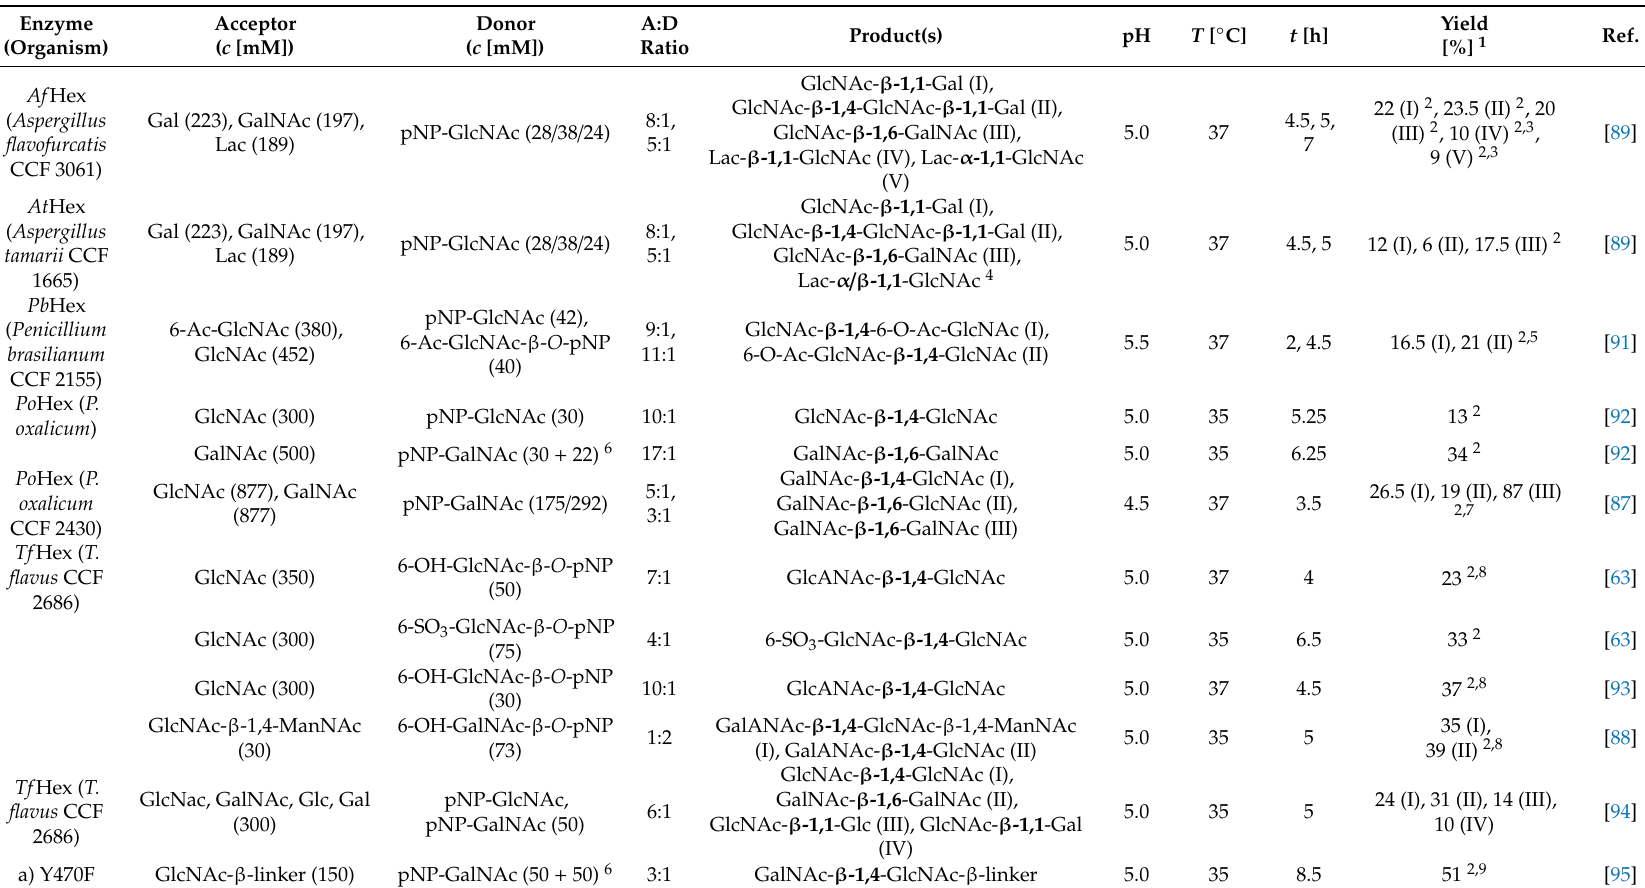
Table 4. Trans-glycosylation reactions catalyzed by fungal GH20 β - N -acetyl hexosaminidases using pNP-activated carbohydrate donor substrates. New bonds are highlighted in